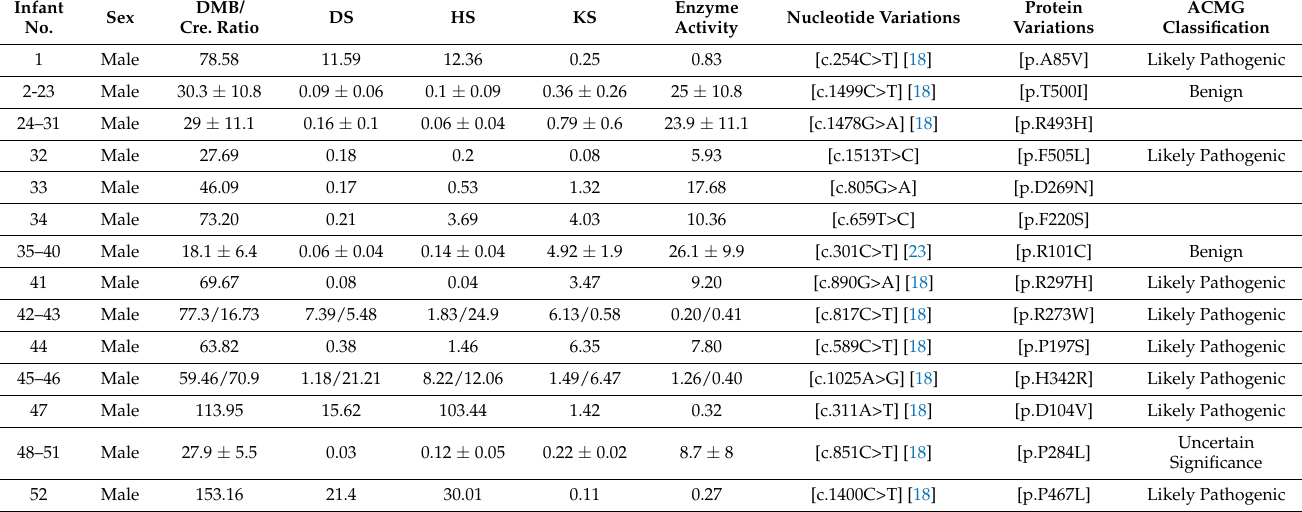
Table 2. Biochemistry GAG tests, enzyme activity, and mutations of Iduronate 2-Sulfatase (IDS) gene in suspected MPSII infants. Infant